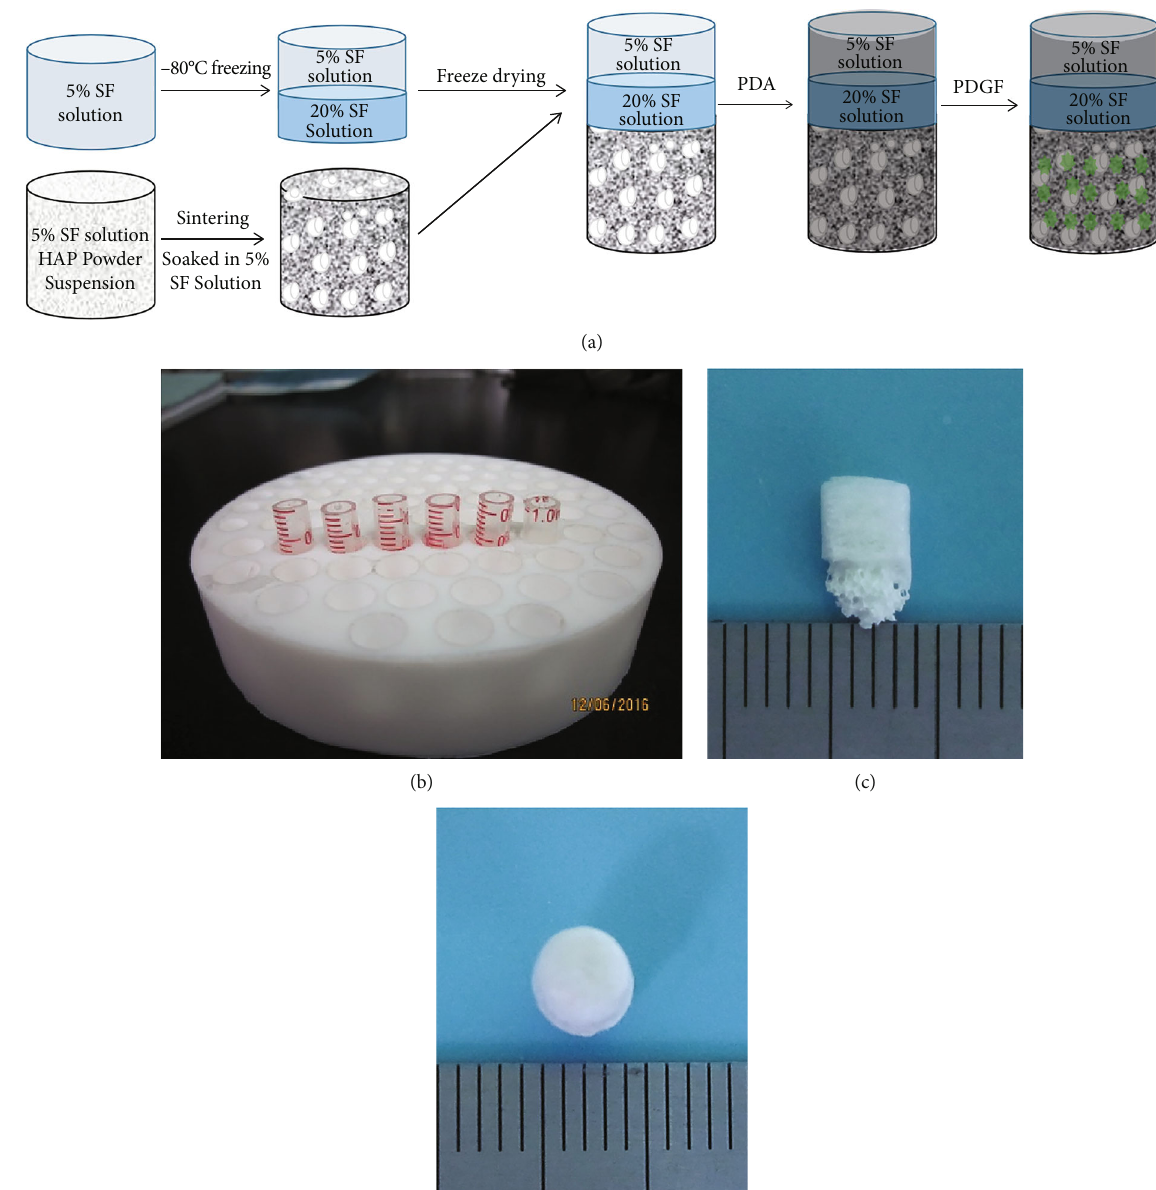
Figure 1: (a) Schematic illustration of the preparation of the three-phase sca ff old. (b) Custom mold for making sca ff old. The pro fi le (c) and vertical (d) appearance of sca ff